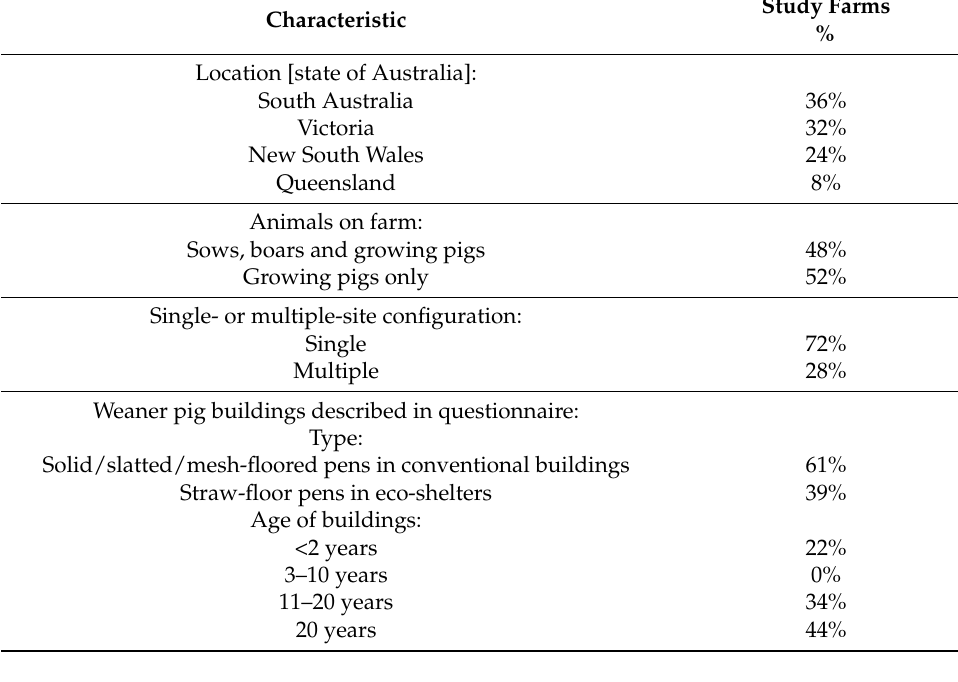
Table A2. Cont. Characteristic Grower/finisher pig buildings described in